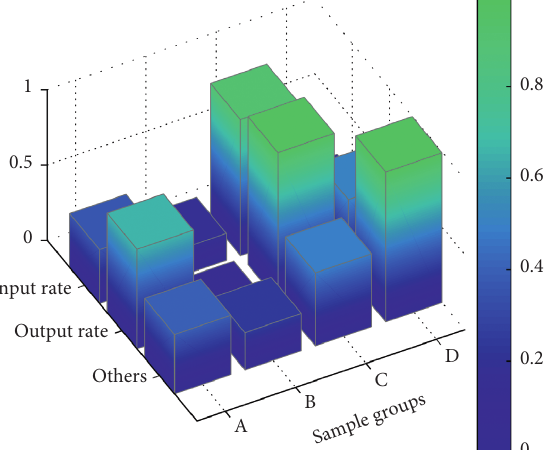
Figure 6: Comparison of floating-point input and output means of various multivisual animation samples.